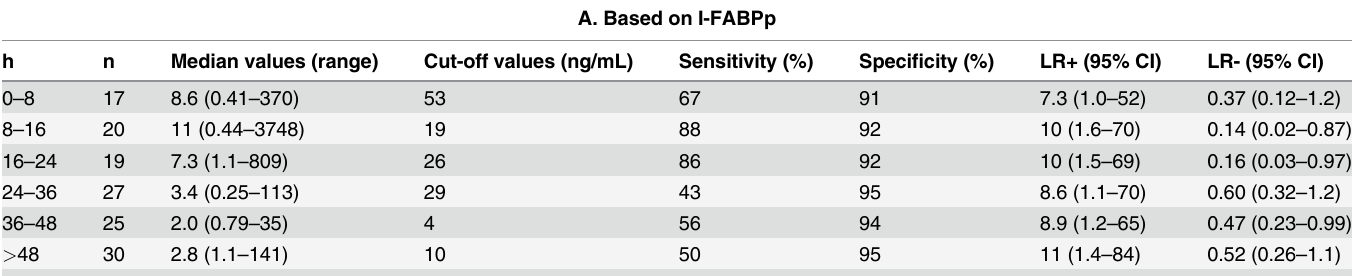
Table 4. Cut-off values, likelihood ratios, and other test characteristics of I-FABPp (A) and I-FABPu (B) as a predictive test for the development of complicated disease (both NEC and otherwise) from 0 – 48 h after onset of symptoms (n = 37). A. Based on